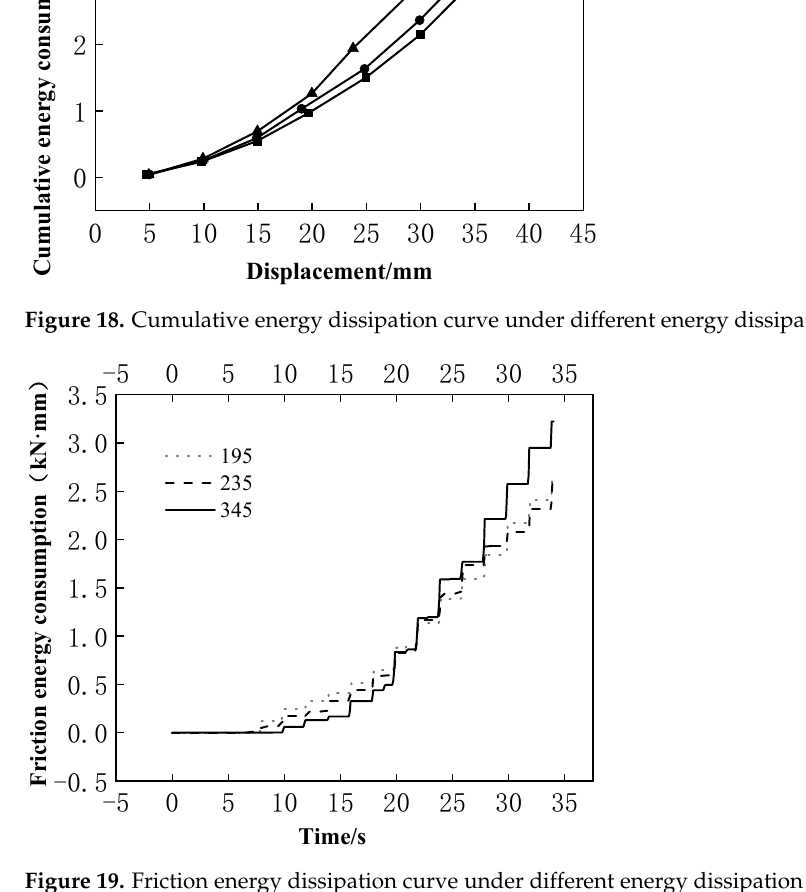
Figure 19. Friction energy dissipation curve under different energy dissipation ring strengths.